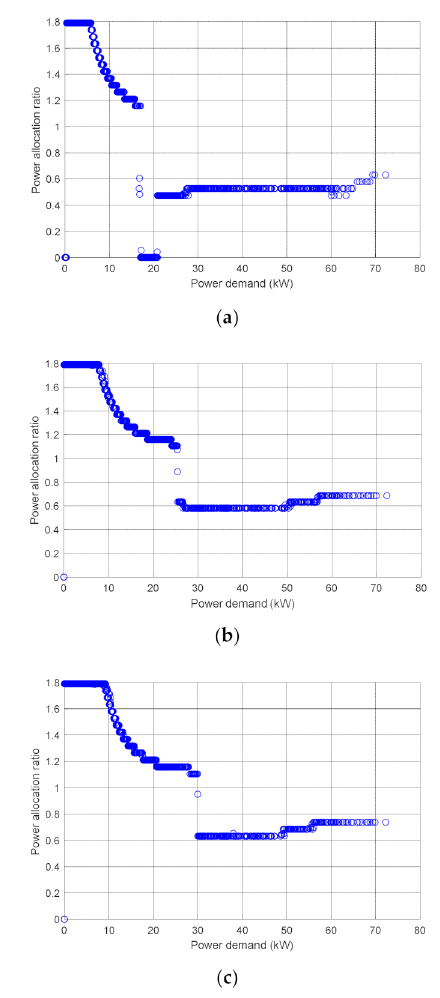
Figure 12. The power allocation ratio, par = P fcs / P dem under different initial SOC values: ( a ) initial SOC value is 0.8; ( b ) initial SOC value is 0.6; ( c ) initial SOC value is